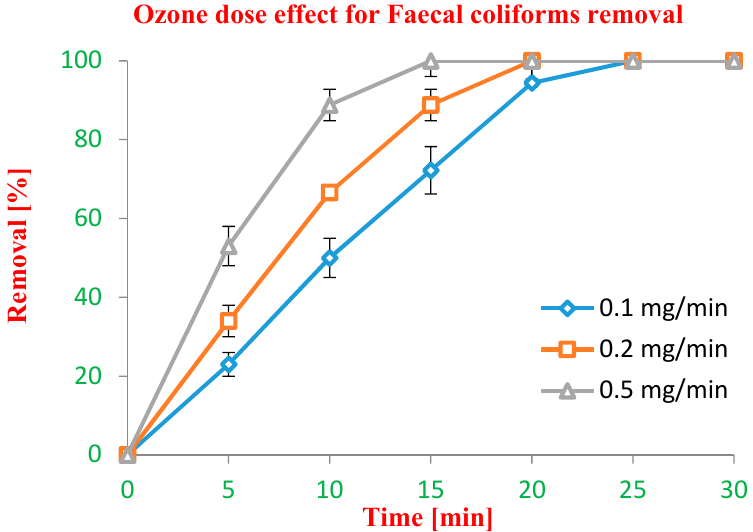
Figure 8. Ozone dose effect in faecal coliforms removal studies during ozonation process (initial faecal coliforms =16 ± 3 MPN/100 mL, ozone dose = 0.1 mg/min, 0.2 mg/min and 0.5 mg/min, Fe-ZA = 10 g/L, pH = 8.1, volume = 1 L, time = 30 min, T= 33 ± 2 ◦ C).